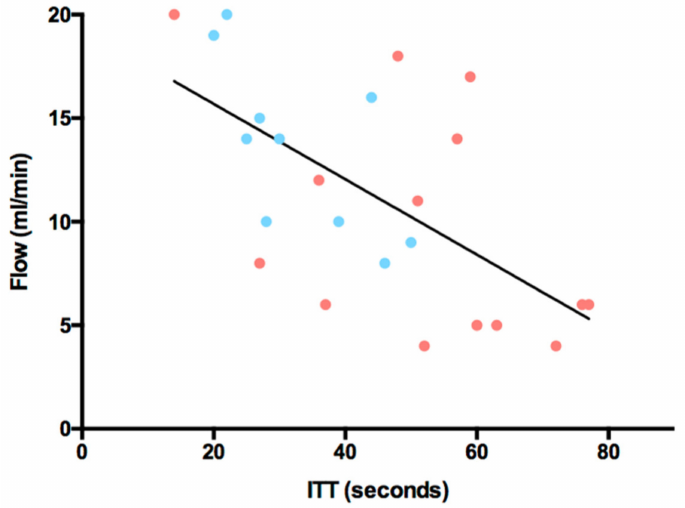
Figure 5. Arterial blood flow (mL/min) versus Intrinsic Transit Time (ITT, seconds); y = − 0.182x + 19.33; p = 0.001; r2 = 0.3875; red dots = DIEP flaps; blue dots = ms-TRAM flaps.